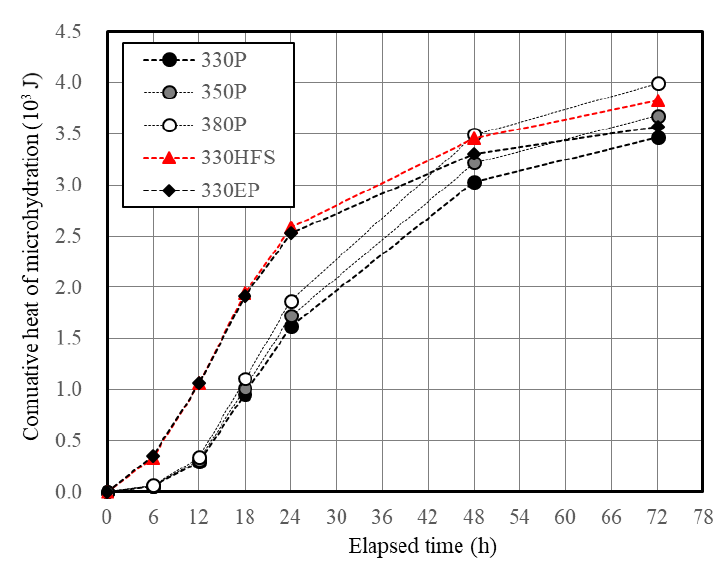
Figure 9. Variation in cumulative heat of microhydration according to each cement.